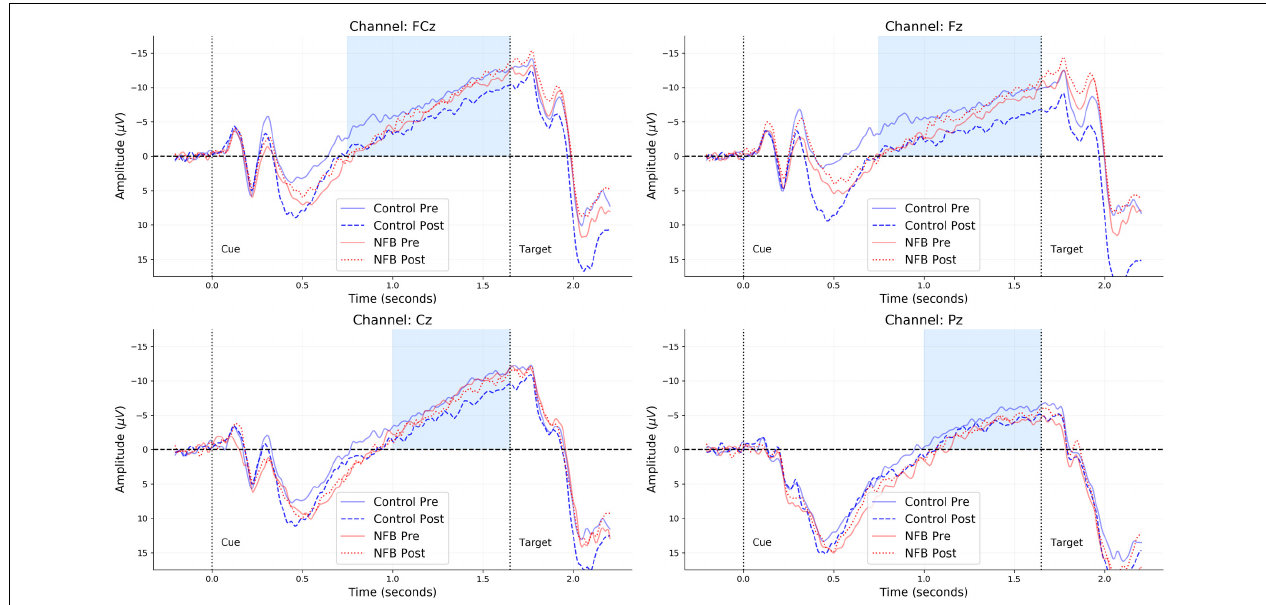
FIGURE 2 | Grand-averaged CNV waveforms for each of the four channels (FCz, Fz, Cz, and Pz) obtained from each group (neurofeedback vs. control) and time point (pre vs. post). The light blue regions indicate the time-window considered for computing the mean CNV amplitude within each trial of the CPT.